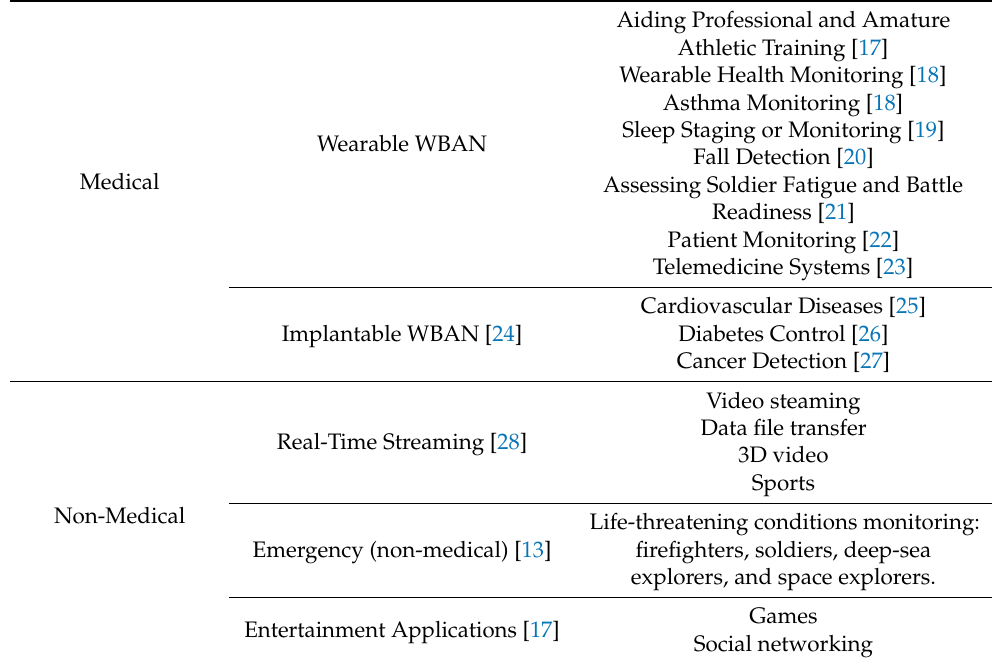
Table 1. Some typical applications of